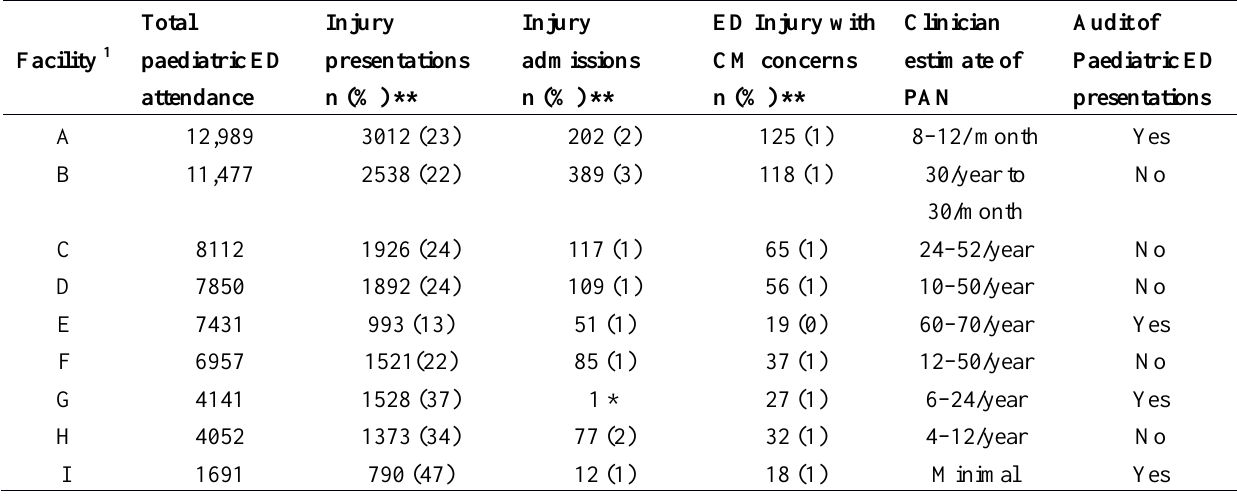
Table 1. Correlation of paediatric injury presentations with clinician estimates of child maltreatment.